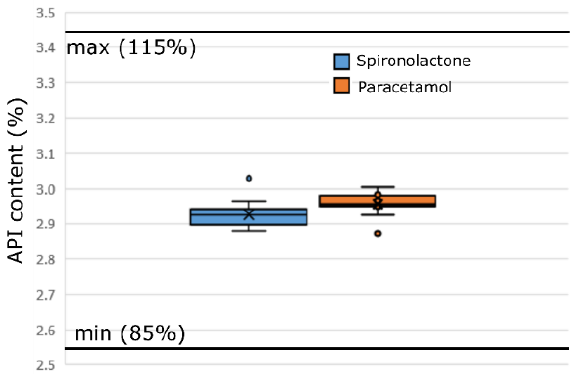
Figure 7. Box plot of API contents with specification limits.